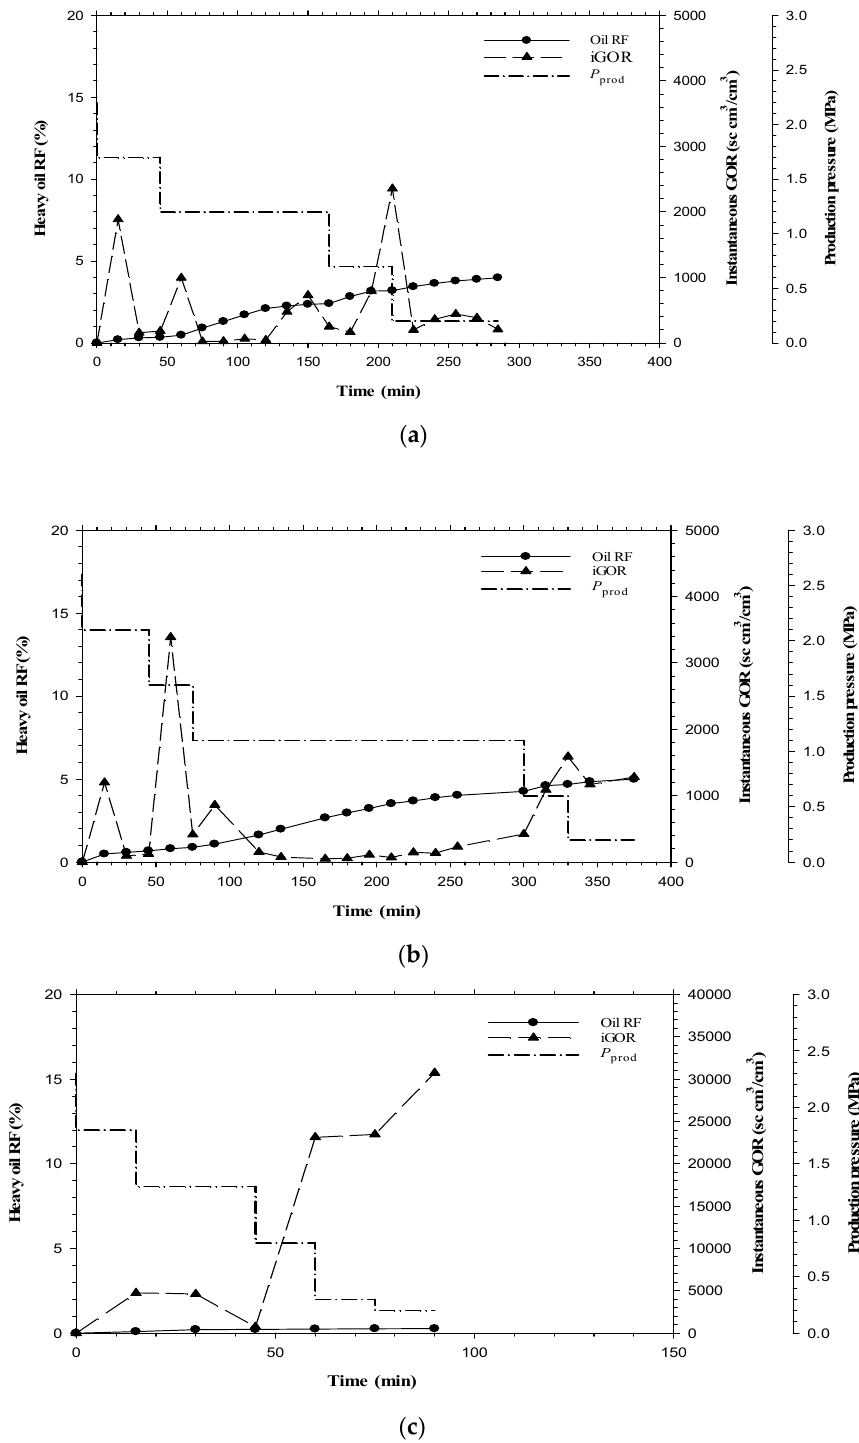
Figure 8. Measured heavy oil recovery factors (RFs), instantaneous gas-oil ratios (iGORs), and production pressures ( P prod ) in CO 2 -GPC process at ∆ P EOR = 0.5 MPa (Test #5) ( a ) Cycle #1; ( b ) Cycle #2; and ( c ) Cycle #3.